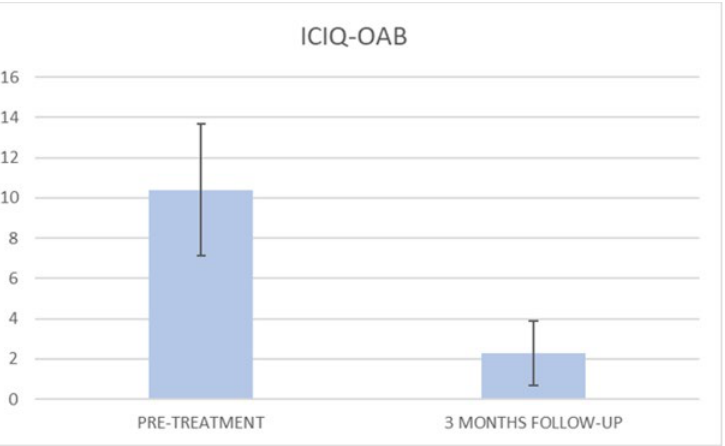
Figure 4. Histogram representation of the results from ICIQ-OAB at baseline and at each treatment session until the 6th treatment session.